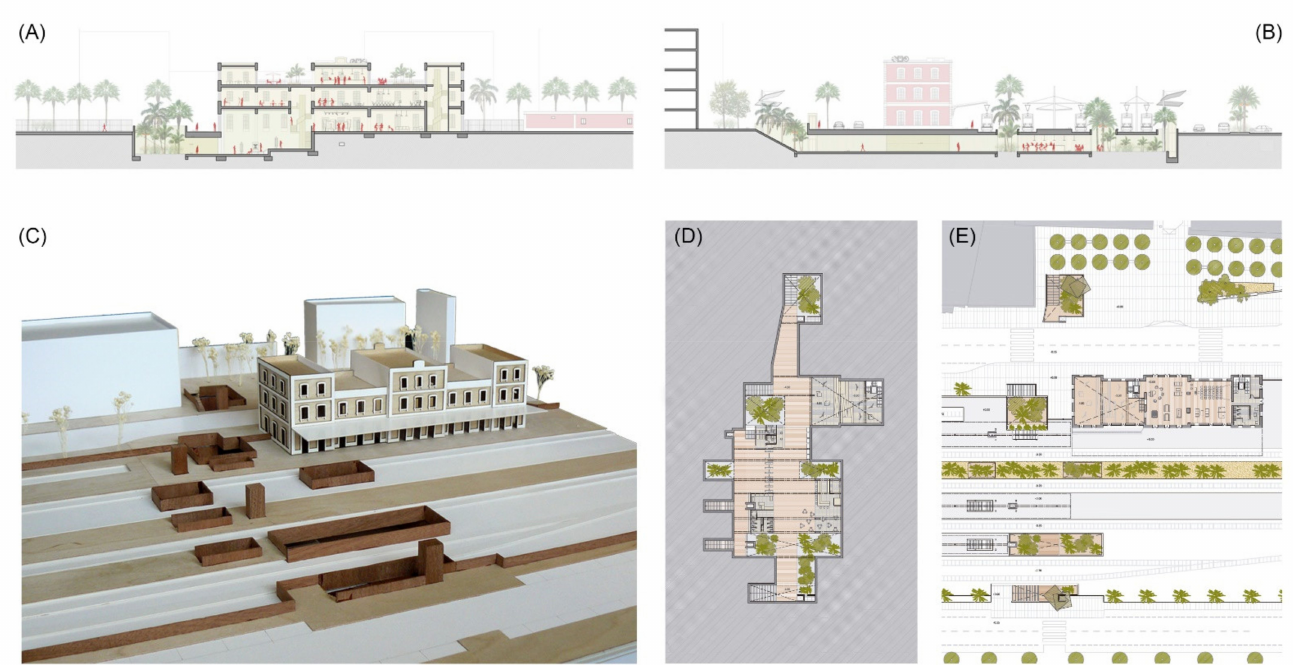
Figure 11. Urban and architectural project for the case study of the railway station of Matar ó (Source: authors’ own). ( A ) Section of the historic building and lobby. ( B ) Transversal section of the underground passage. ( C ) Model picture of the station. ( D , E ) Basement and ground floor plans with green courtyards and an underground structure following the railway